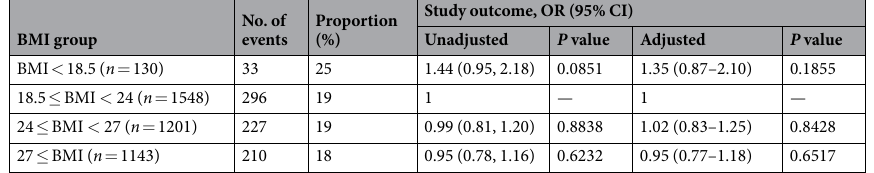
Table 4. Association between BMI and the risk of eGFR progression among patients with CKD stages 1–5. Models were adjusted for age, sex, DM, CAD, Stroke, cancer, hypertension, Charlson score, TB, COPD, ACEI, ARB, fibrate, smoking, alcohol consumption, betel nut chewing, UPCR and eGFR. OR, odds ratio; CI, confidence interval; BMI, body mass index; DM, diabetes mellitus; CAD, coronary artery disease; CKD; chronic kidney disease; UPCR, urine protein-to-creatinine ratio; eGFR, estimated glomerular filtration